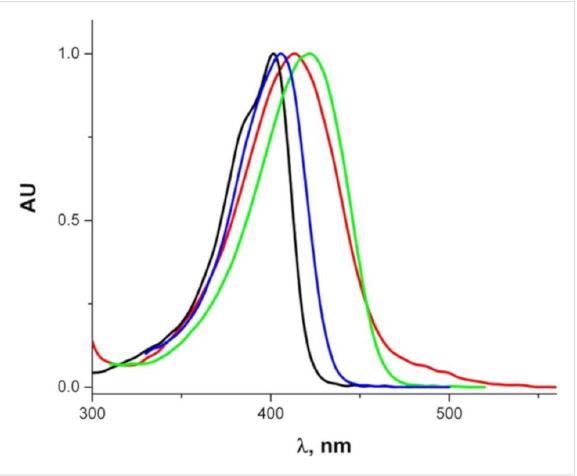
Figure 5: Normalized absorption spectra of 3 in: toluene (black), ace- tone (blue), ethanol (green), water (red).